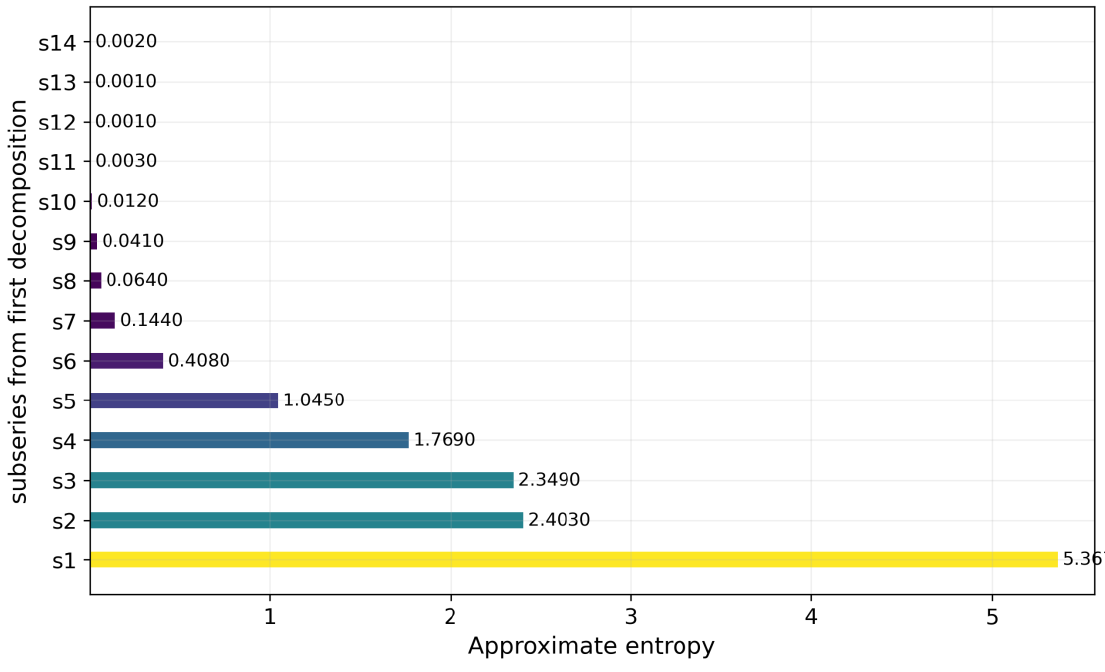
Figure 11. CEEMDAN and AE calculation.